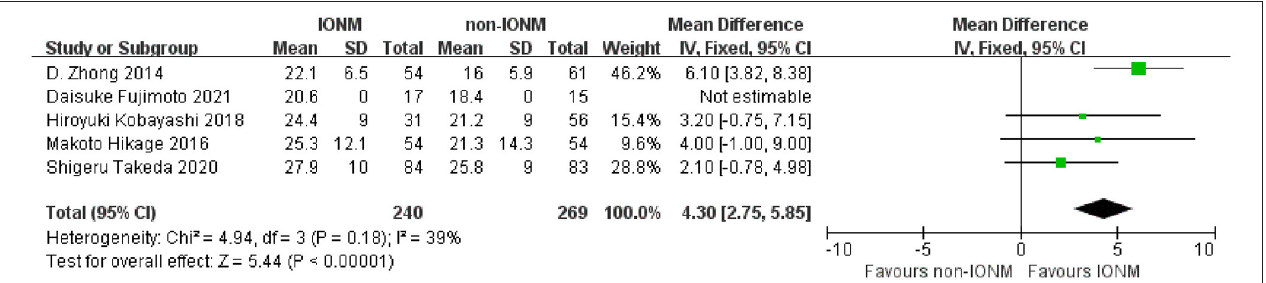
FIGURE 3 | Forest plot of dissected mediastinal lymph nodes in the IONM and non-IONM groups.